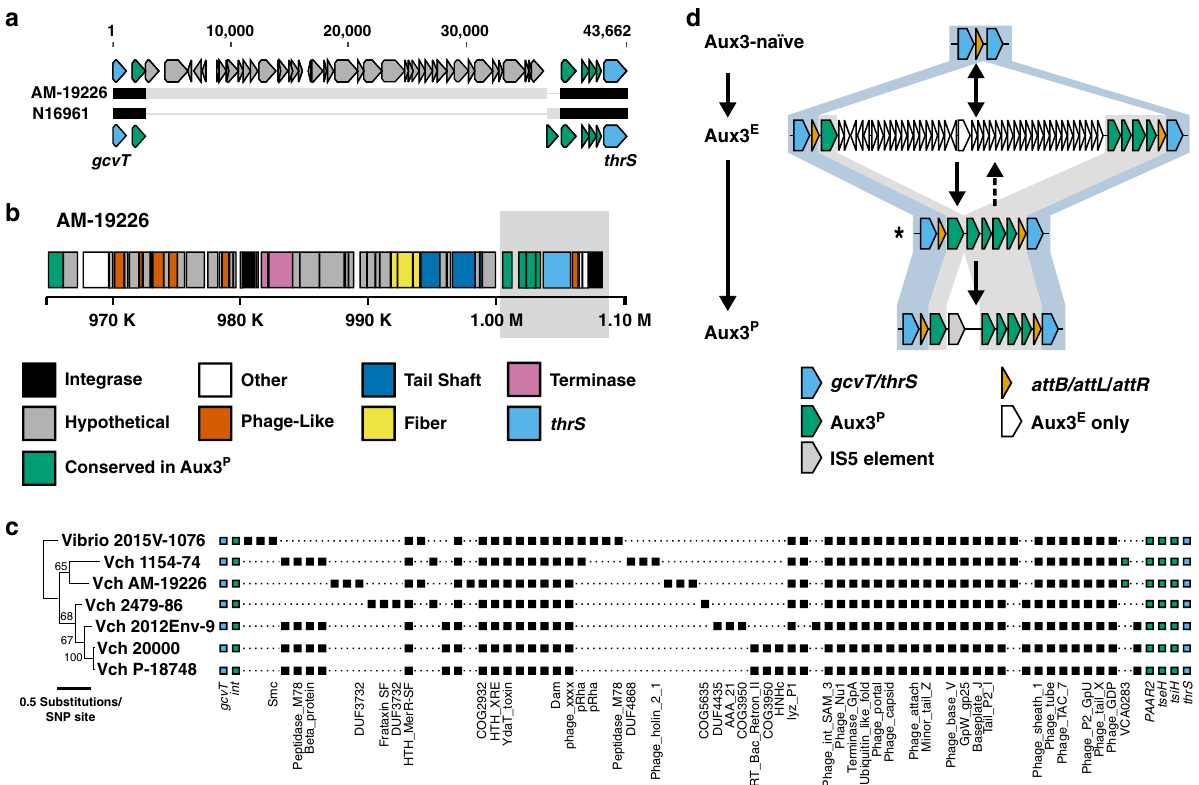
Fig. 2 Environmental tseH -encoding V. cholerae strains carry an alternative prophage-like Aux3 element. a MAUVE alignment of Aux3 from pandemic strain N16961 and environmental strain AM-19226. Flanking genes are shown in blue. Pandemic Aux3 genes are shown in green. Black bars indicate nucleotide agreements and grey bars indicate differences. b PHASTER genome diagram showing predicted Aux3 prophage region from the leading integrase (VCA0281) through the superintegron integrase (VCA0291) in AM-19226. Coding regions are coloured according to homology to broad categories of known phage genes. Light grey box indicates region not called by PHASTER but veri fi ed manually. c Maximum-likelihood tree of Aux3 E modules based on core gene SNPs with associated Aux3 E gene content. Each fi lled box indicates a gene in the Aux3 module of the associated strain. Conserved genes (>70% amino acid identity) are aligned vertically. Conserved domain hits are indicated. Bootstrapping support values are indicated next to their respective branches. d Schematic of proposed Aux3 module evolution from Aux3-naïve environmental to Aux3 P strains. Conserved regions between steps are highlighted in light blue (environmental to pandemic Aux3 P ) or grey (Aux3 E to Aux3 P ). Asterisk indicates a putative unseen intermediate stage in Aux3 evolution. Dashed arrow indicates alternate hypothesis of a large insertion to form Aux3 E